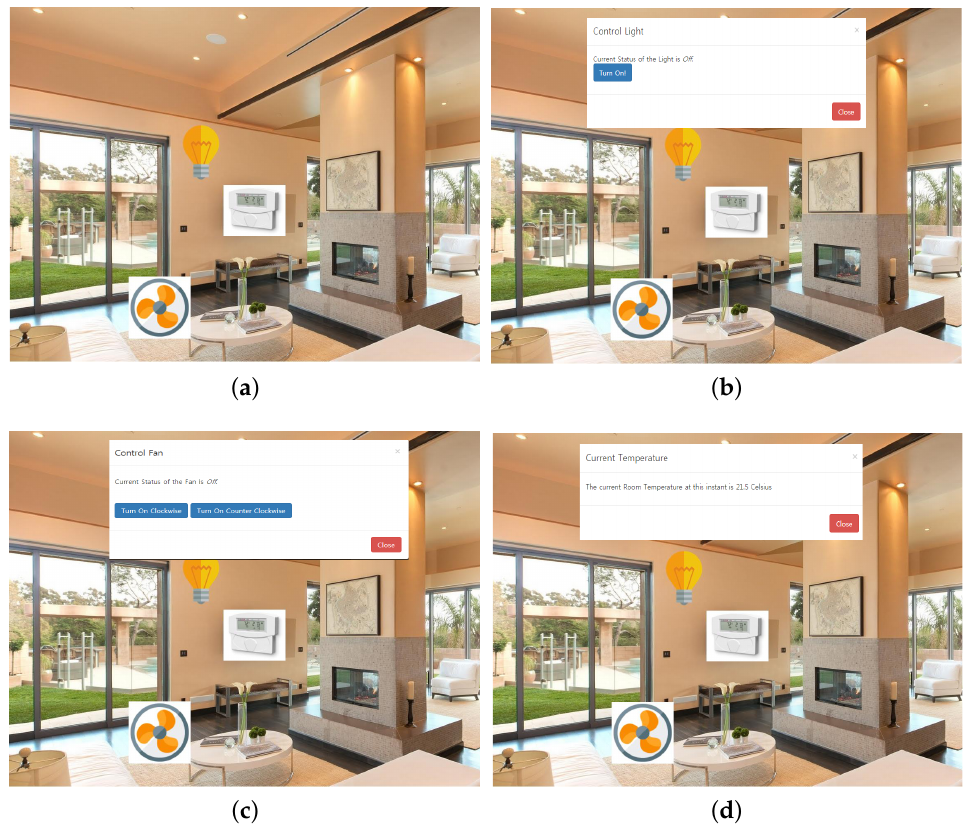
Figure 14. Smart home snapshots. ( a ) Smart home initial view; ( b ) Light control; ( c ) Fan control; ( d ) Temperature